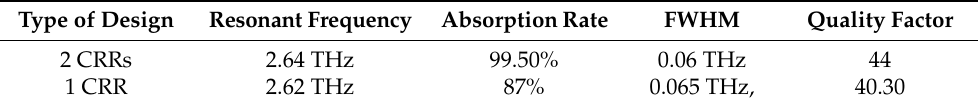
Table 2. Performance comparison for design with single and double CRRs.